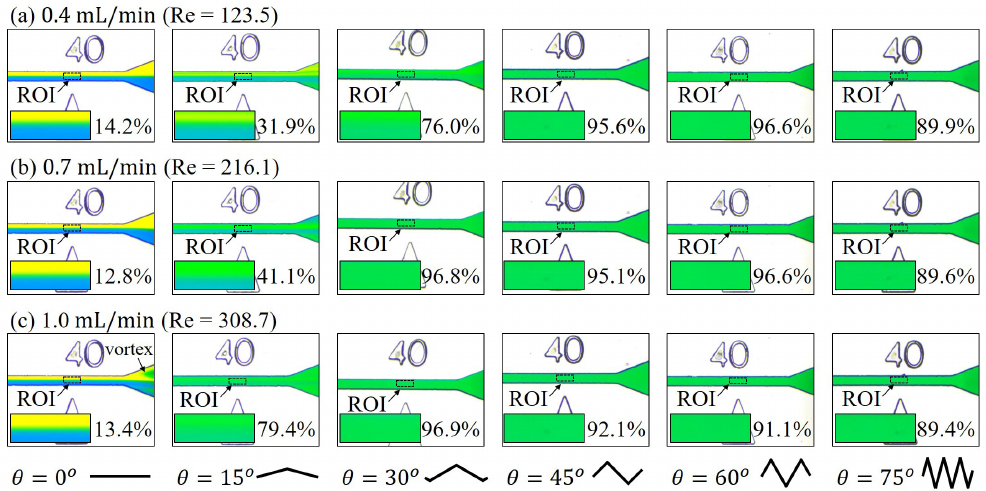
Figure 8. Experimental results of mixing with six different zigzag angles at high flow rates.